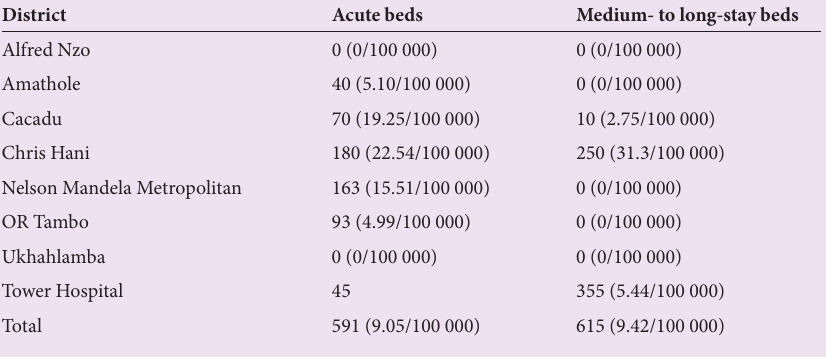
Table 2. Public sector psychiatric beds per region, n (bed/population ratios) District Acute beds Medium- to long-stay